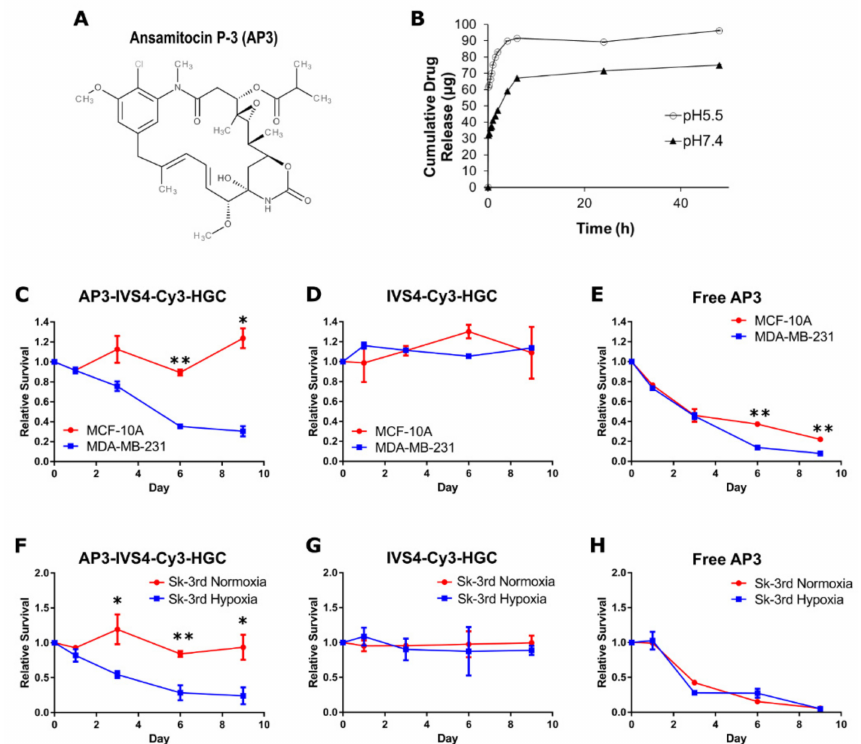
Figure 5. Ansamitocin P3-encapsulated NPs present a pH-dependent release and effectively kill triple- negative breast cancer cells and breast cancer stem cells overexpressing MMP-14 at the